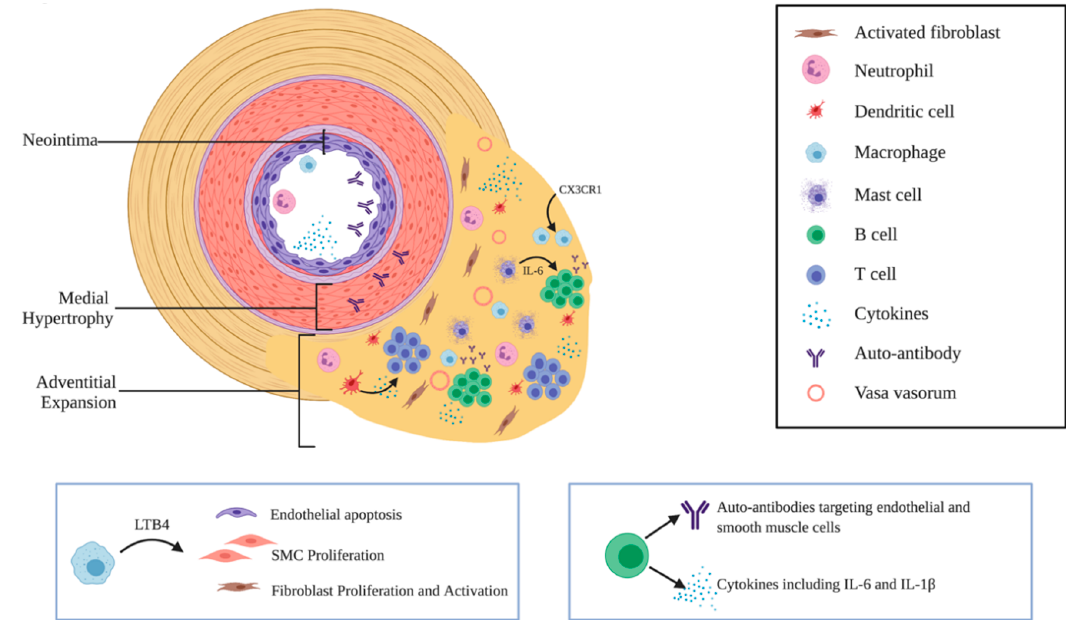
Figure 1. Vascular Remodeling in PAH is driven by inflammation. Pulmonary vascular lesions in PAH patients exist in an extremely inflamed micro-environment. See text for details. Note the changes to each layer of the vessel wall, including neointimal formation, medial hypertrophy, and adventitial expansion. Adventitial fibroblasts become activated and secrete cytokines and chemokines to recruit immune cells to the vessel wall via an expanded vasa vasorum. The activation of these recruited immune cells results in the further recruitment of cellular mediators as well as the secretion of cytokines, autoantibodies, and other soluble molecules. Adapted from Rabinovitch et al. Circulation Research 115: 165–175 (2014). Boxes highlight the actions of macrophage LTB4 (Section 2.2.1) and B cells (Section 2.3.5) .